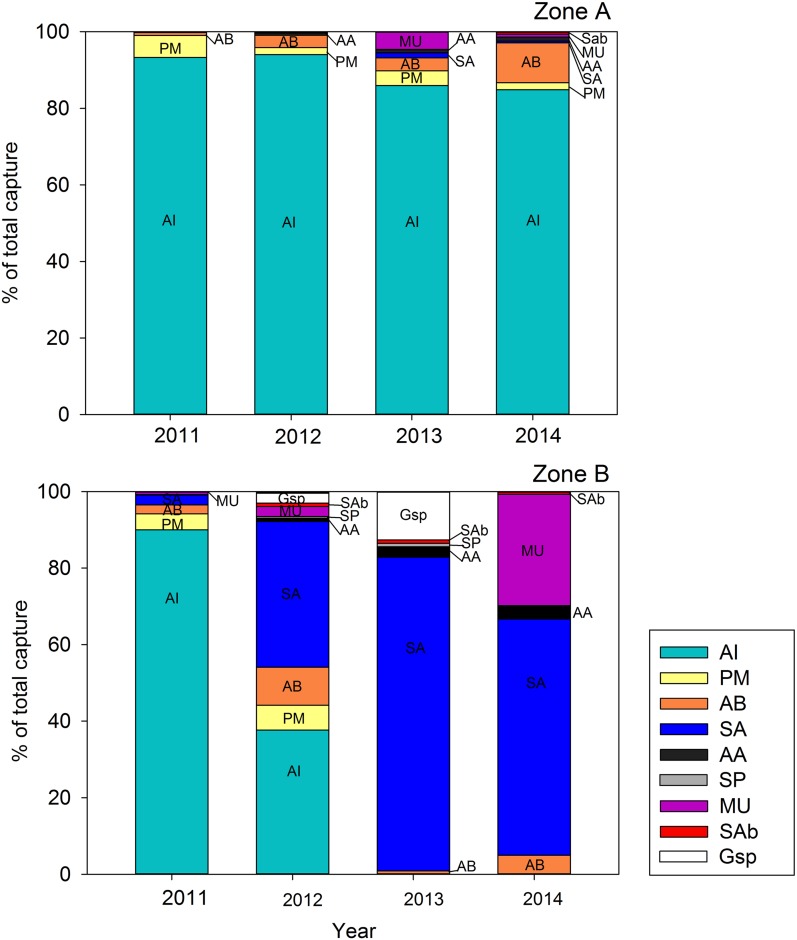
Percent abundance of fish species at each study year (2011–2014) and zone (A and B).AA, A. anguilla (C); PM, P. microps (ES); AB, A. boyeri (ES); AI, A. iberus (ES); SA, S. aurata (MA); MU, mullets (MA); SP, S. pavo (ES); SAb, S. abaster (ES); Gsp, Gobius sp (ES). Ecological guild categories (see text) are indicated in brackets. Other species observed in very low abundances and are not indicated. N2011 = 39,739 (A) and 3,100 (B) individuals; N2012 = 10,286 (A) and 231 (B) individuals; N2013 = 7,381 (A) and 111 (B) individuals; N2014 = 2,072 (A) and 141 (B) individuals.